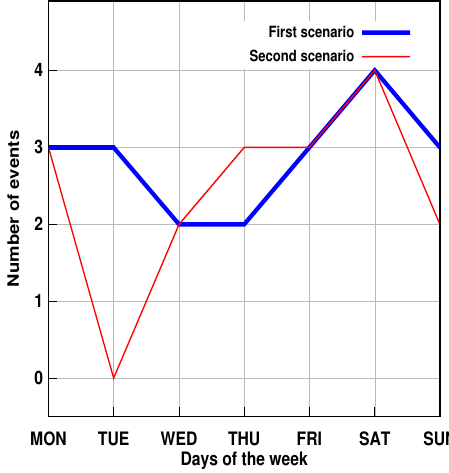
Figure 13. AGGIR Dressing